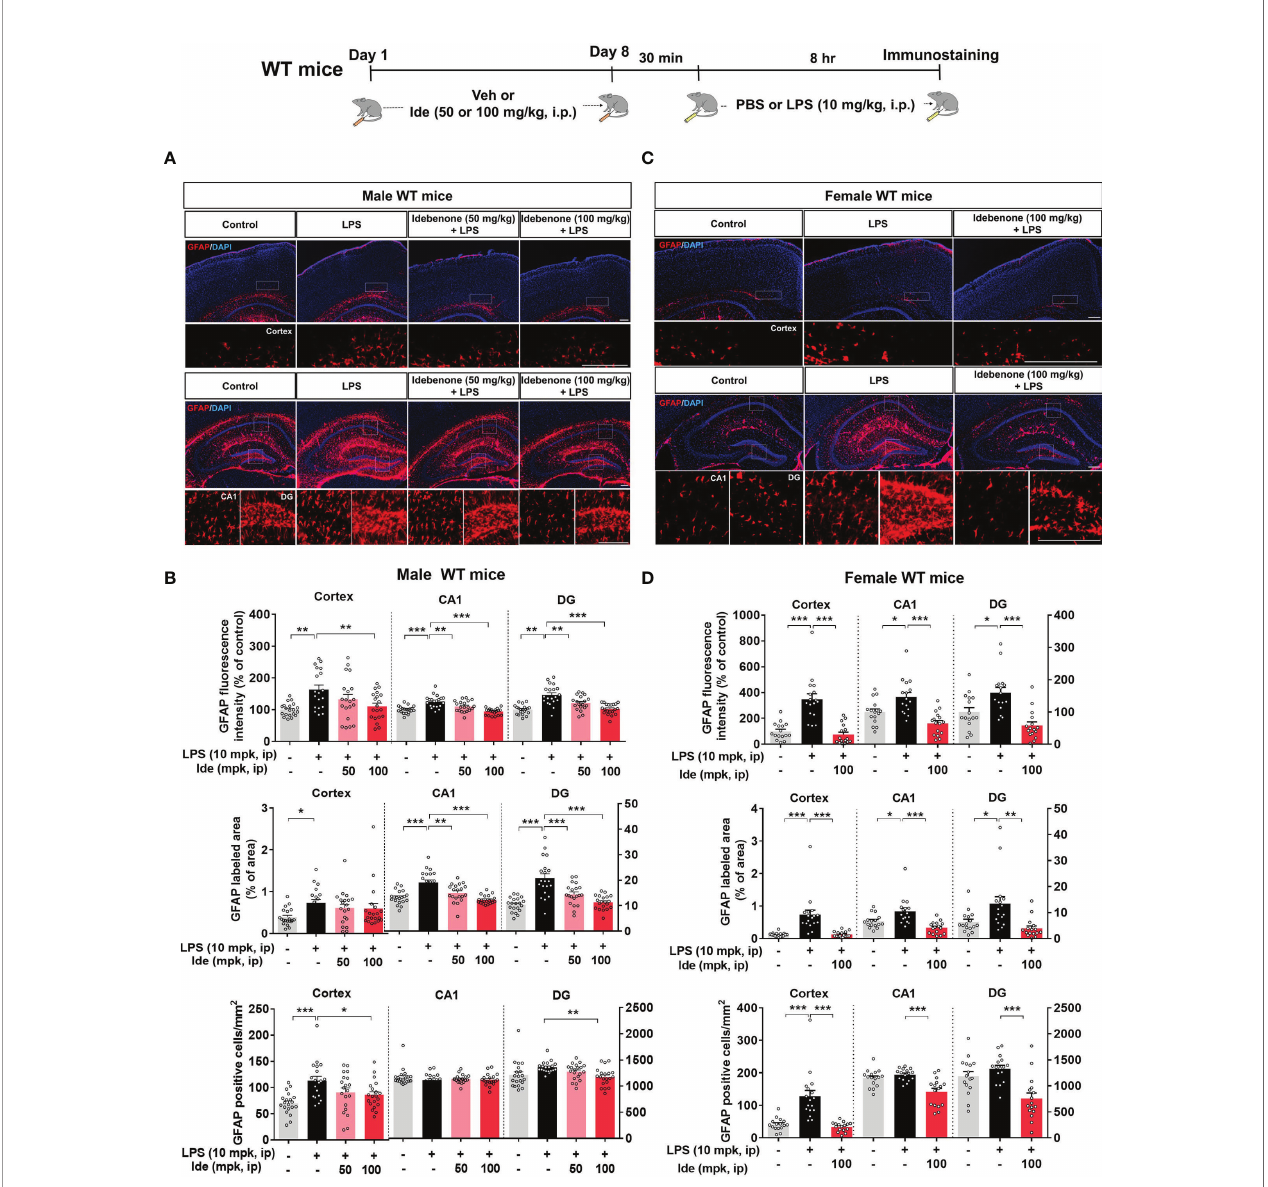
FIGURE 4 | Idebenone suppresses astrogliosis and astrocytic hyperplasia and proliferation in LPS-injected male and female wild-type mice. (A, C) Representative images of GFAP immuno fl uorescence in the cortex and hippocampus. Idebenone (50 or 100 mg/kg, i.p.) or vehicle was administered to male and female wild-type mice daily for 8 consecutive days. Thirty minutes after the fi nal injection, LPS (10 mg/kg, i.p.) or PBS was administered, and 8 h later, the mice were sacri fi ced, and brain tissue was immunostained with an anti-GFAP antibody. (B, D) Quanti fi cation of the fl uorescence intensity of GFAP; GFAP-immunolabeled area; and number of GFAP-positive cells (Male WT: n = 19 – 20 brain slices from 5 mice/group; Female WT: n = 16 – 17 brain slices from 4 mice/group). *p < 0.05, **p < 0.01, and ***p < 0.001. Scale bar = 200 m